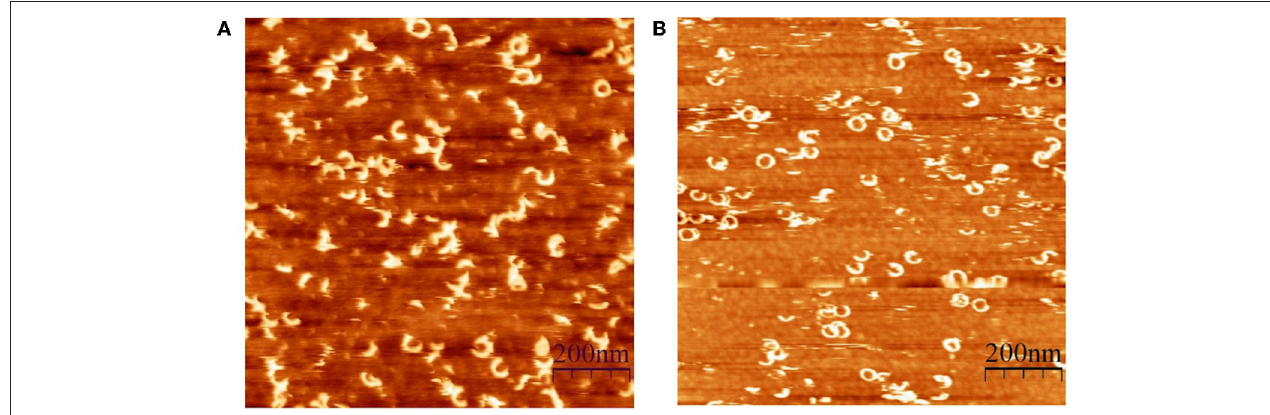
FIGURE 4 | Atomic force microscopy topography images of the ring and arciform-shaped structures obtained after reconstitution of INY (A) and VLY (B) into tBLMs (reproduced with permission from Ragaliauskas et al.,